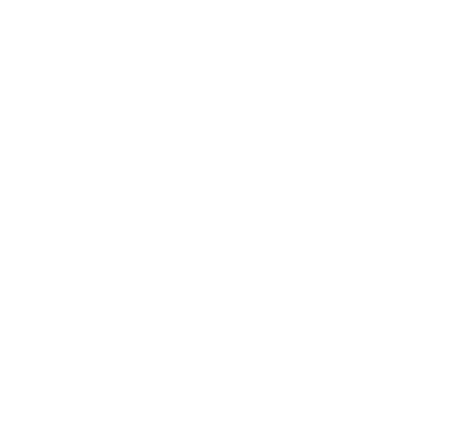
Figure 7. Model depicting how Phlpp1 ablation may affect osteoclastogenesis and bone mass in female mice.